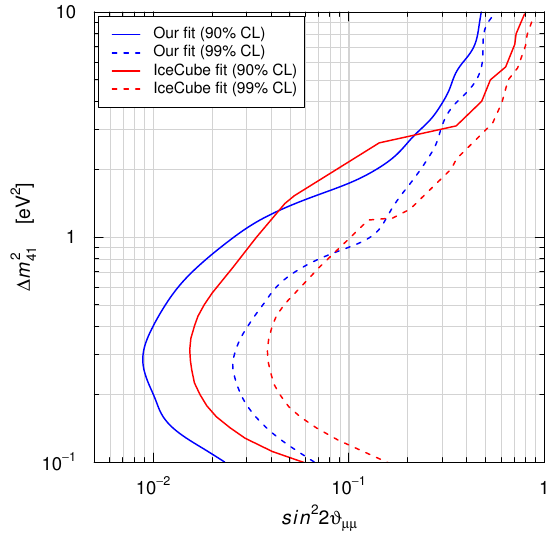
Figure 7 . Comparison of the o(cid:14)cial IceCube 90% and 99% CL exclusion curves in the sin 2 2 # (cid:22)(cid:22) { (cid:1) m 2 plane [36] with our results. All curves have been obtained assuming j U e 4 j 2 = j U (cid:28) 4 j 2 = 0. 41